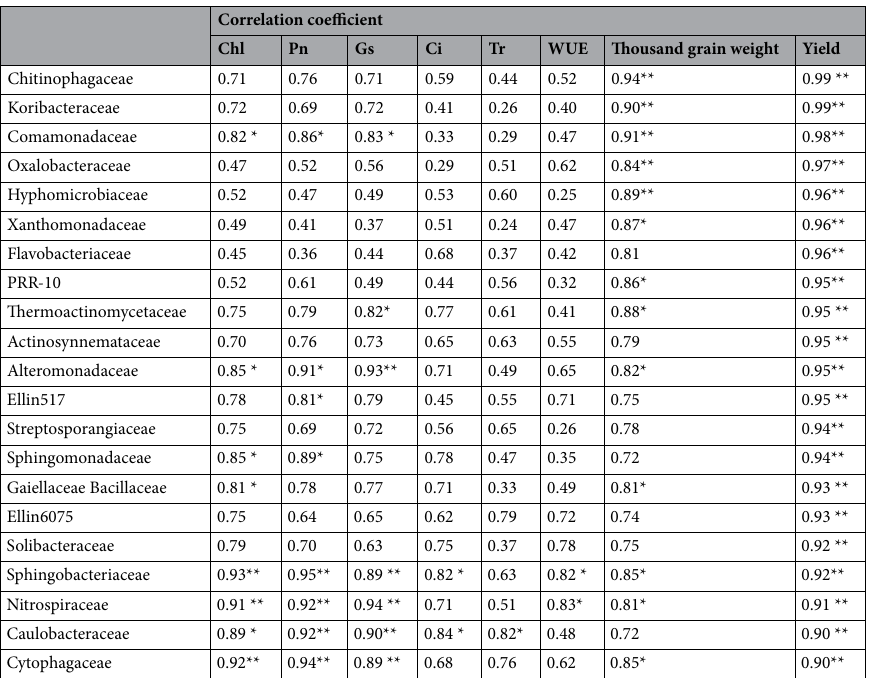
Table 3. Correlation analysis of photosynthetic parameters, yield and thousand grain weight of sorghum with major soil microorganisms. There are a large number of microbial populations associated with sorghum yield formation, and this table compares 21 groups of bacteria selected for highly significant correlation with yield based on yield and microbial correlation. *Indicates significant difference at 0.05 level, ** indicates significant difference at 0.01